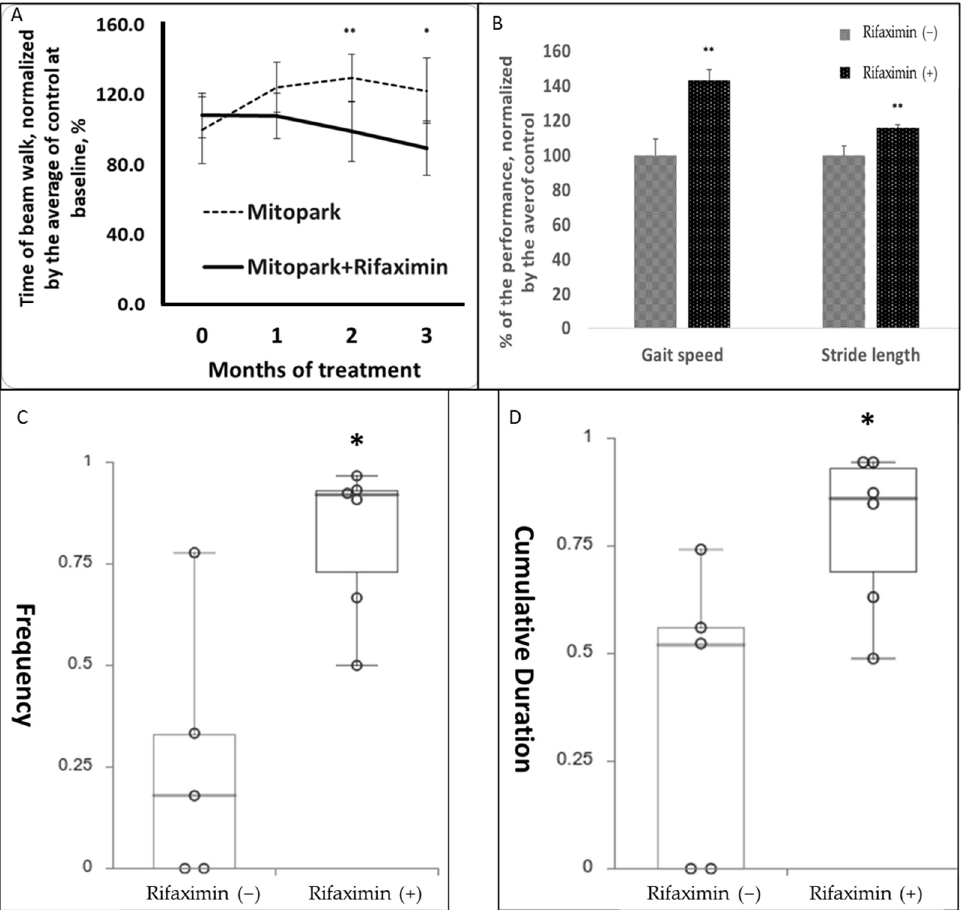
Figure 3. Effect of rifaximin treatment on motor and memory function in MitoPark mice. The behavioral test results of MitoPark mice that were or were not treated with rifaximin for 3 months. ( A ) Rifaximin treatment prevented a decline in the motor performance of the MitoPark mice in the beam walk assessment after 2 and 3 months of treatment. ( B ) The MitoPark mice that were treated with rifaximin for 3 months exhibited higher gait speed and longer stride length than did the nontreated MitoPark mice. ( C , D ) The dot and box plot demonstrated that the rifaximin-treated MitoPark mice were significantly more likely to make contact with the novel object (frequency) and stay longer (cumulative duration) with the novel object in the novel object recognition assessment, which indi- cated better memory. Data are presented as the mean ± standard deviation ( A , B ) or medians with the first and third quartiles ( C , D ). *, p < 0.05, **, p < 0.01.